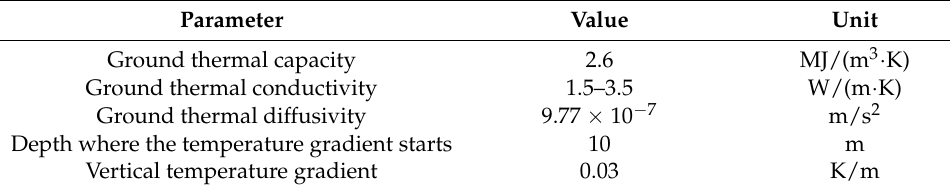
Table 3. Physical properties of the soil, own representation according to